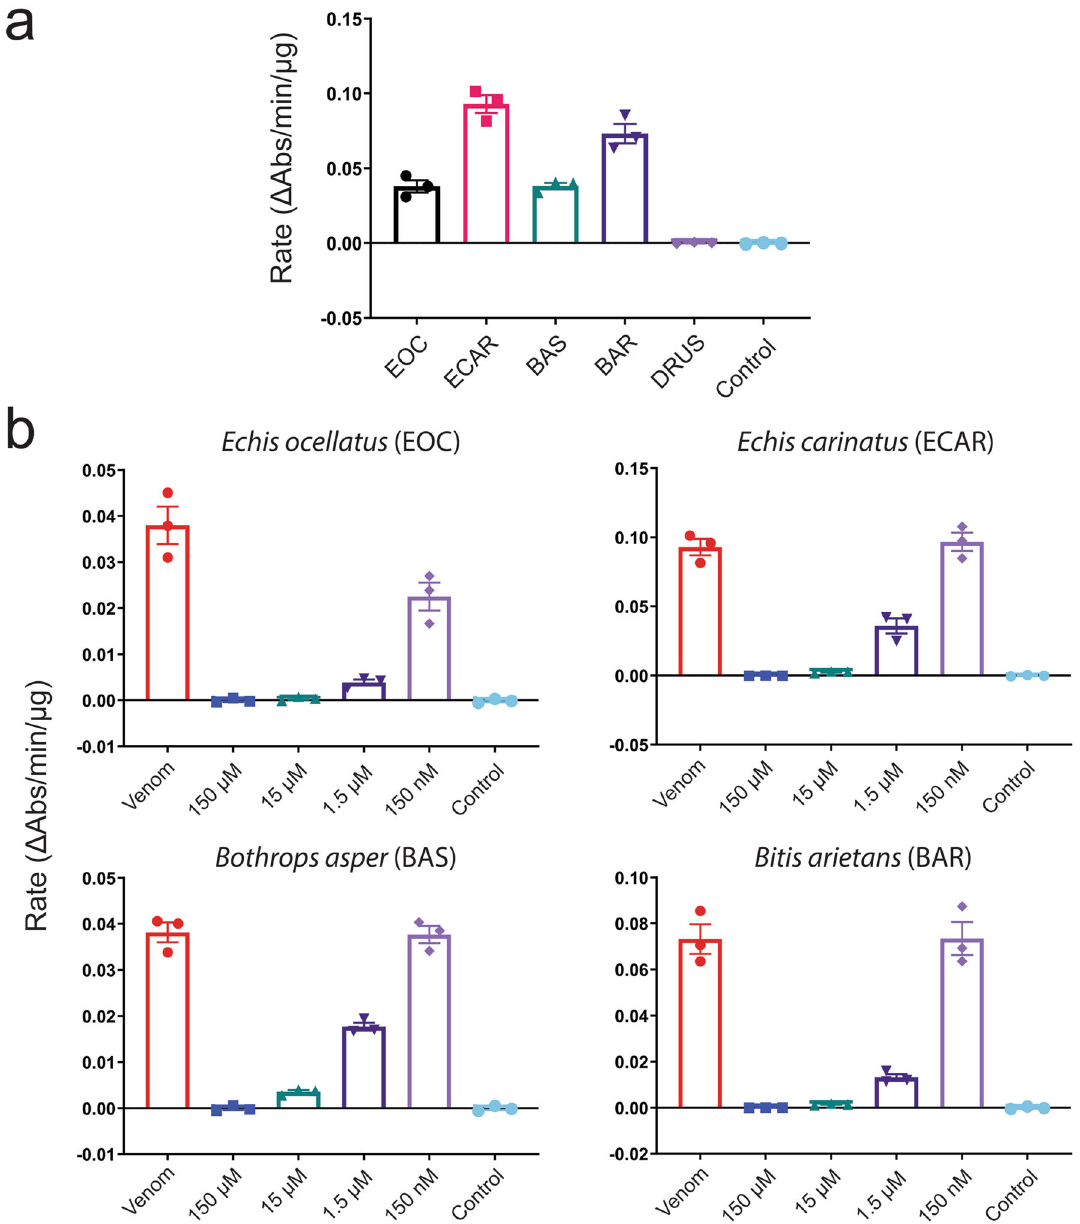
Fig. 4 Nafamostat inhibits the in vitro serine protease activities of several geographically distinct viper venoms. a The serine protease (SVSP) activity of fi ve viper venoms expressed as the rate ( Δ Abs/time/ µ g venom) of substrate consumption determined by kinetic chromogenic assay. The data represents triplicate independent repeats with SEMs, where each technical repeat represents the mean of n ≥ 2 technical replicates. EOC E. ocellatus ; ECAR E. carinatus ; BAS Bothrops asper ; BAR Bitis arietans ; DRUS Daboia russelii . b Neutralization of SVSP venom activity by the serine protease-inhibitor nafamostat. The data is expressed as rates ( Δ Abs/time/ µ g venom) and represents triplicate independent repeats with SEMs, where each technical repeat represents the mean of n ≥ 2 technical replicates. Venom only activity (venom) is displayed alongside venom incubated with decreasing molarities of nafamostat (150 µ M to 150 nM). Note the different y-axis scales. Source data provided in Supplementary Data